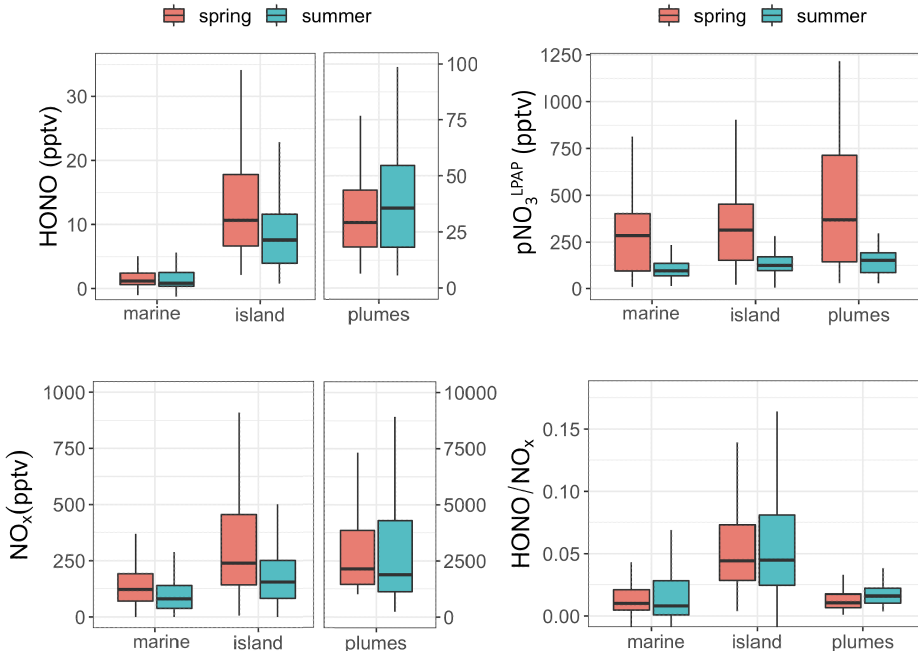
concentrations and HONO / NO x ratios in clean marine air, island-influenced Figure 3. Whisker plots comparing HONO, NO x , and pNO LPAP 3 air, and polluted plumes during the spring and the summer field campaigns in Bermuda. The thick lines represent median values, the boxes the 25th and 75th percentiles, and the whiskers the largest value within 1.5 times the interquartile range above the 75th percentile and the smallest value within 1.5 times the interquartile range below the 25th